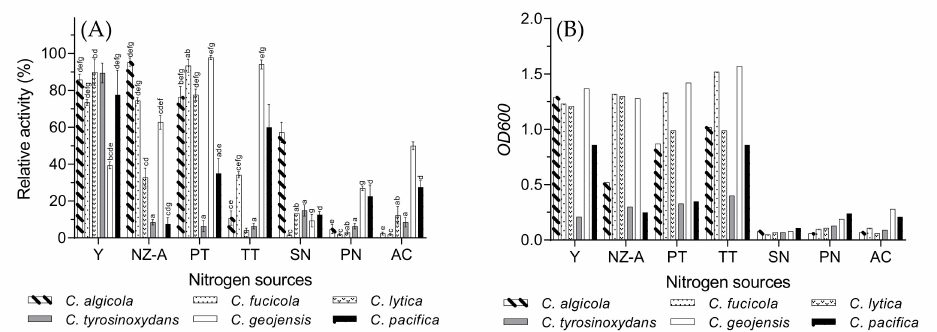
Figure 5. The effects of different nitrogen sources on Cellulophaga species on ( A ) ι -carrageenase production and ( B ) cell growth presented as optical density ( OD 600 ). Values of Figure 5A are expressed as mean ± SEM (n = 4). Data comparison was performed against nitrogen sources. a = when compared with yeast extract (Y), b = when compared with NZ-amine (NZ-A), c = when compared with peptone (PT), d = when compared with tryptone (TT), e = when compared with sodium nitrate (SN), f = when compared with potassium nitrate (PN), g = when compared with ammonium chloride (AC). Different lowercase letters on the bars indicate statistically significant differences from respective group using ANOVA, followed by Tukey’s comparison test ( p <